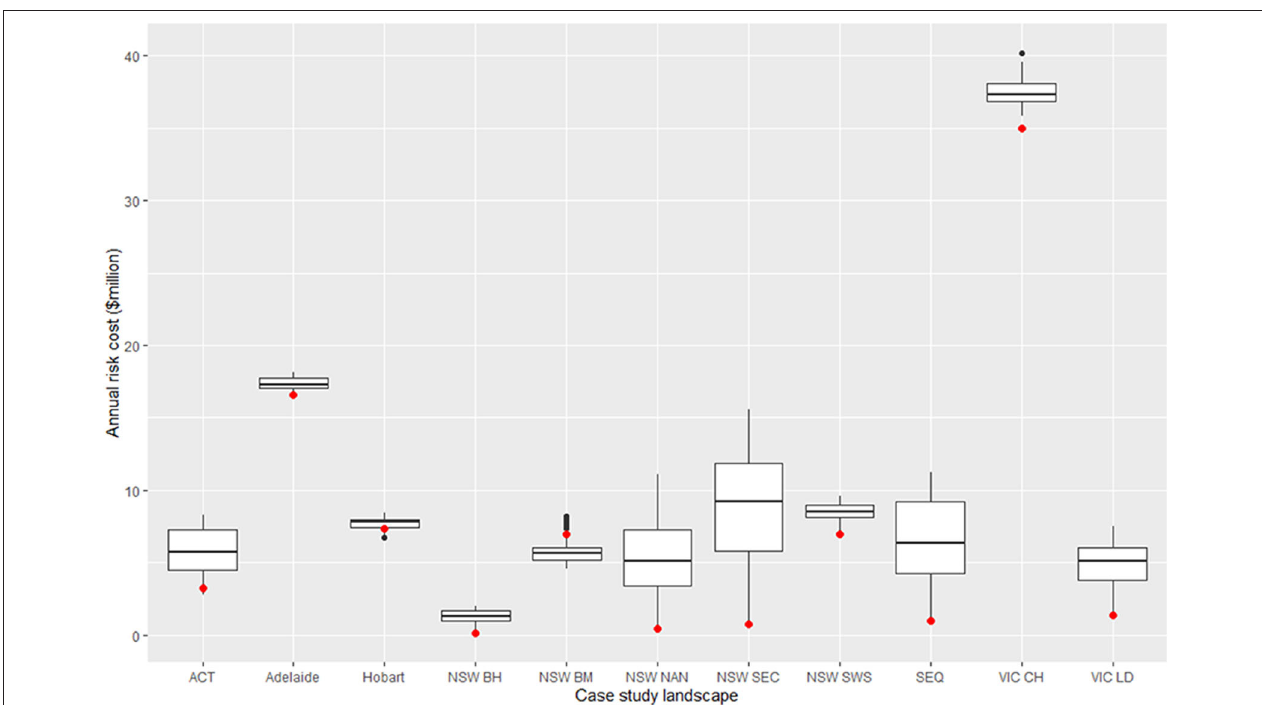
FIGURE 4 | Annualized risk cost across all values and treatments for the case study regions across all treatment rates. Red circle indicates the “do nothing” approach L0E0. See Table 1 for case study codes.